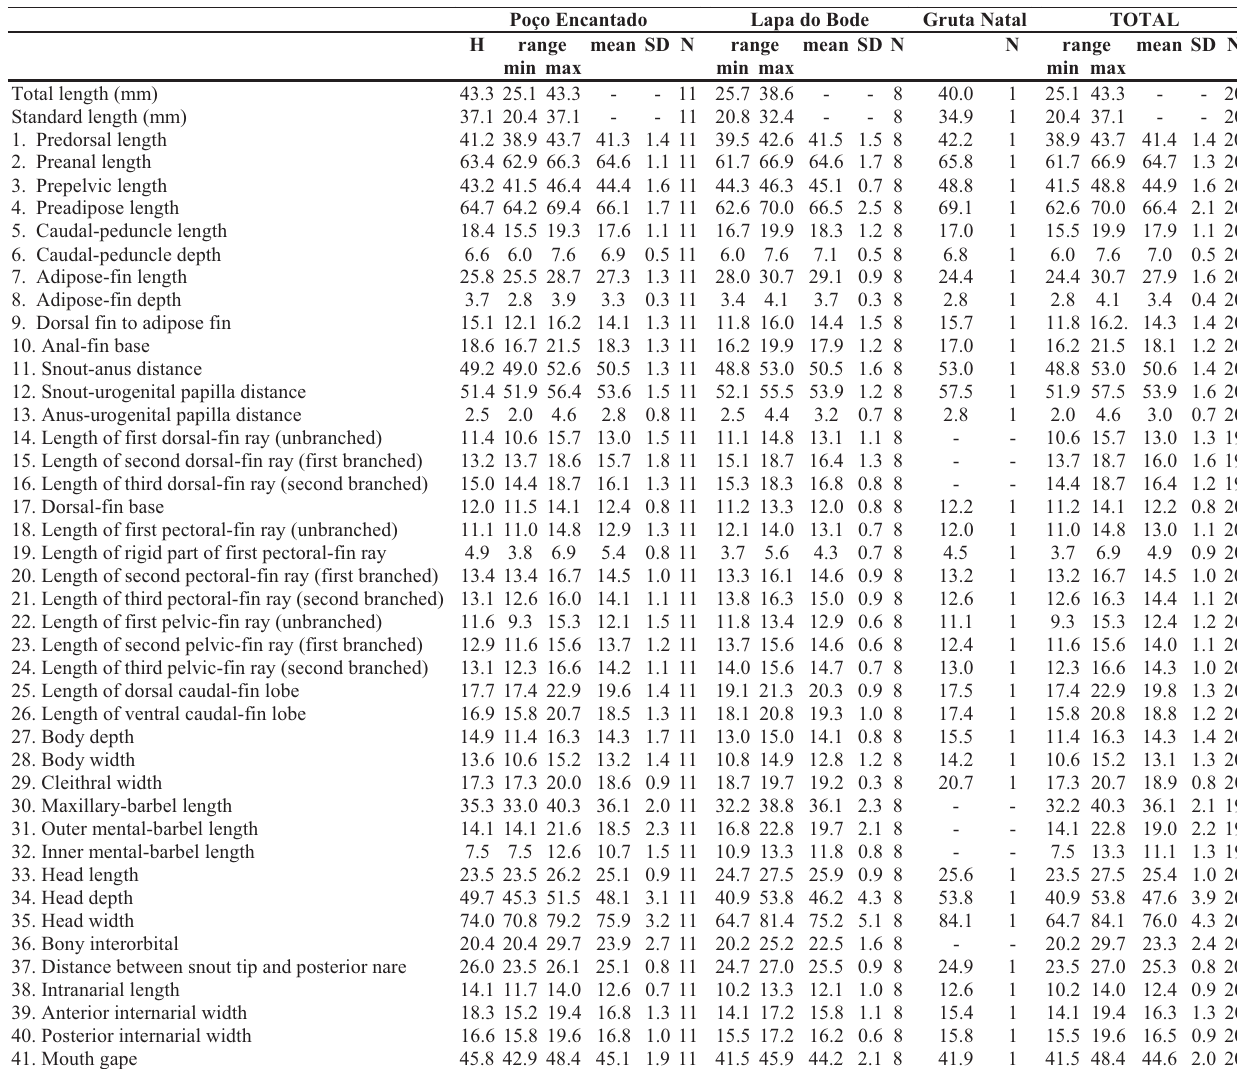
Table 1. Morphometric features of Rhamdiopsis krugi , taken from: LIRP 5929 (holotype, Poço Encantado), LIRP 5930 (paratypes, Poço Encantado), MZUSP 92609 (paratypes, Poço Encantado), LIRP 5928 (paratypes, Lapa do Bode), and LIRP 5931 (paratype, Gruta Natal). Morphometric data 1-33 are expressed as percentage of standard length and 34-41 as percentage of head length. H = holotype; N = number of specimens; SD = Standard deviation. Poço Encantado Lapa do Bode Gruta Natal Total length